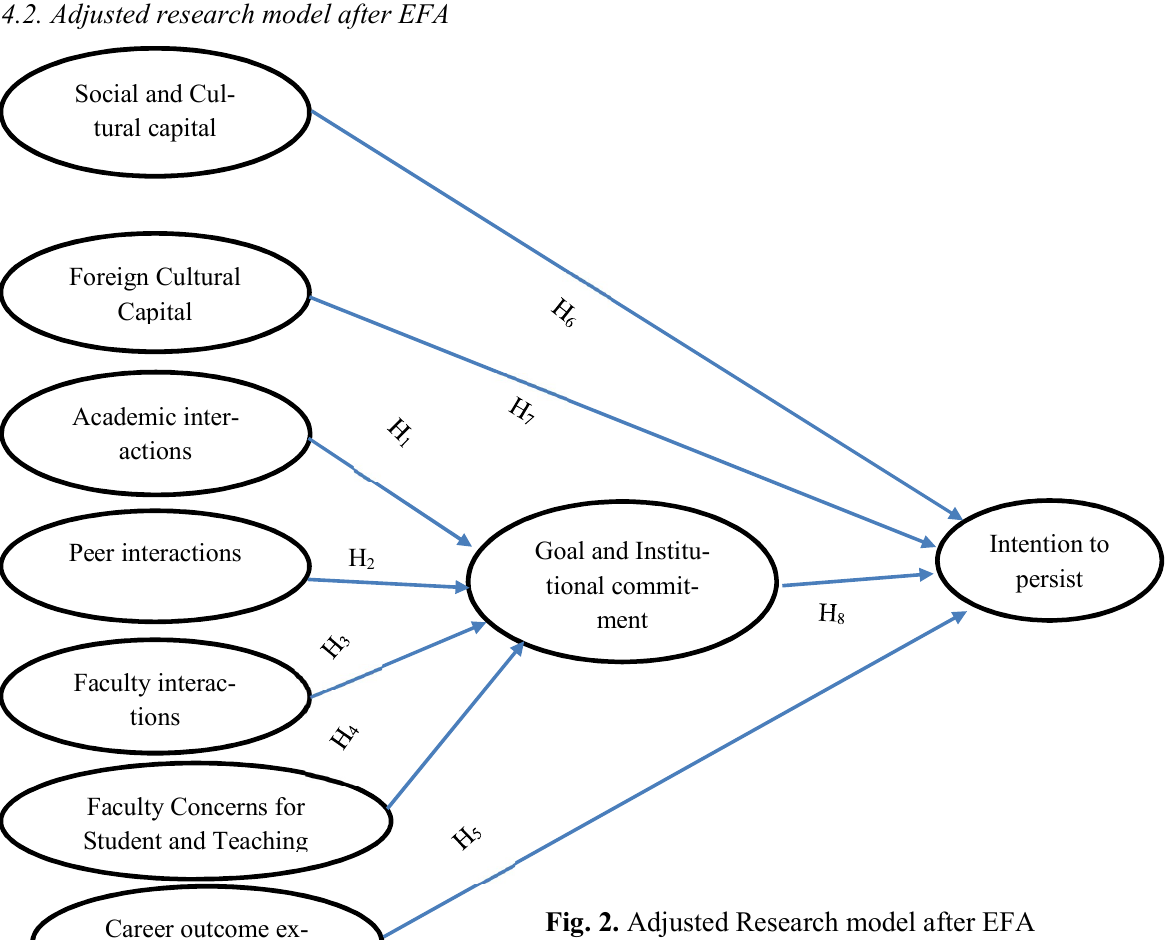
Fig. 2. Adjusted Research model after